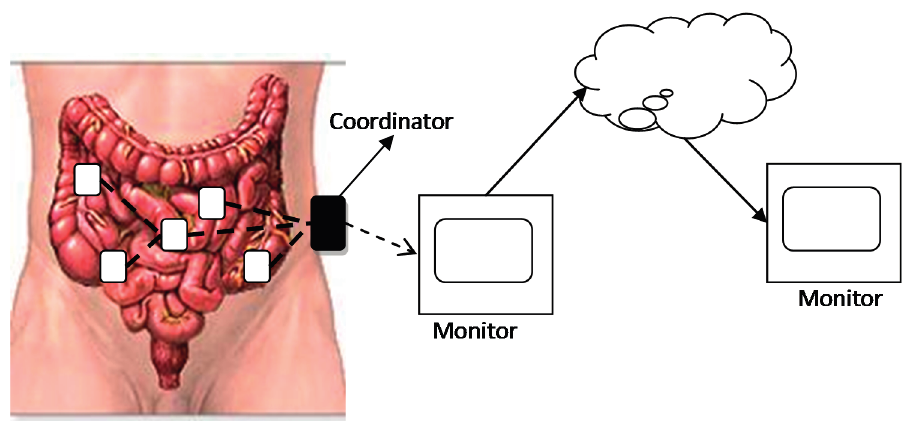
Figure 1. A simple architecture of body sensor